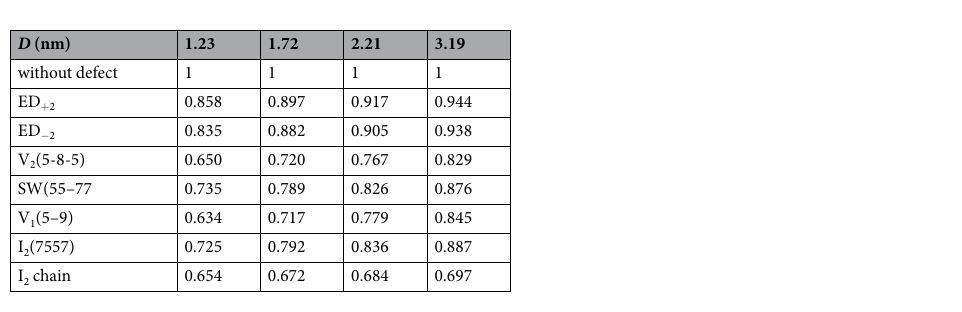
Table 2. Reduction of the thermal conductivity characterized by the coefficient T ph in the case of purely phonon transport along the